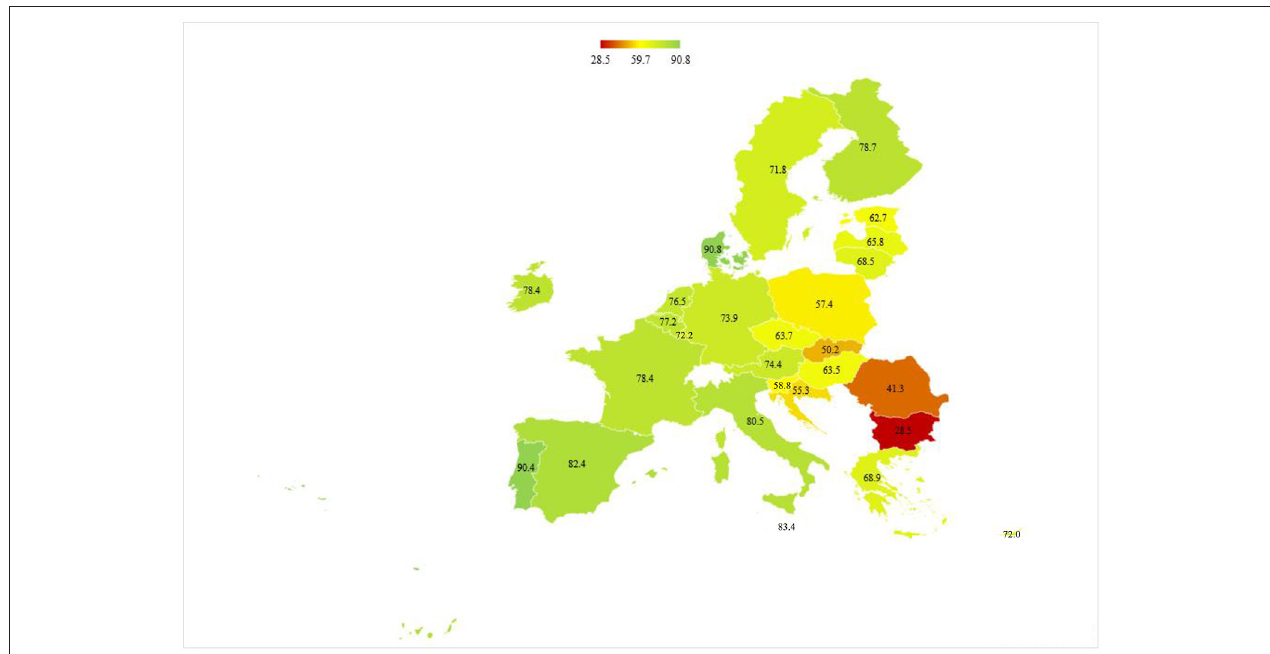
FIGURE 1 | Vaccination rates across the EU, % of the population. The figure shows the percentages of the total population receiving at least one dose of the COVID-19 vaccine by January 4, 2022. Source: Author’s own calculations based on data from ECDC (